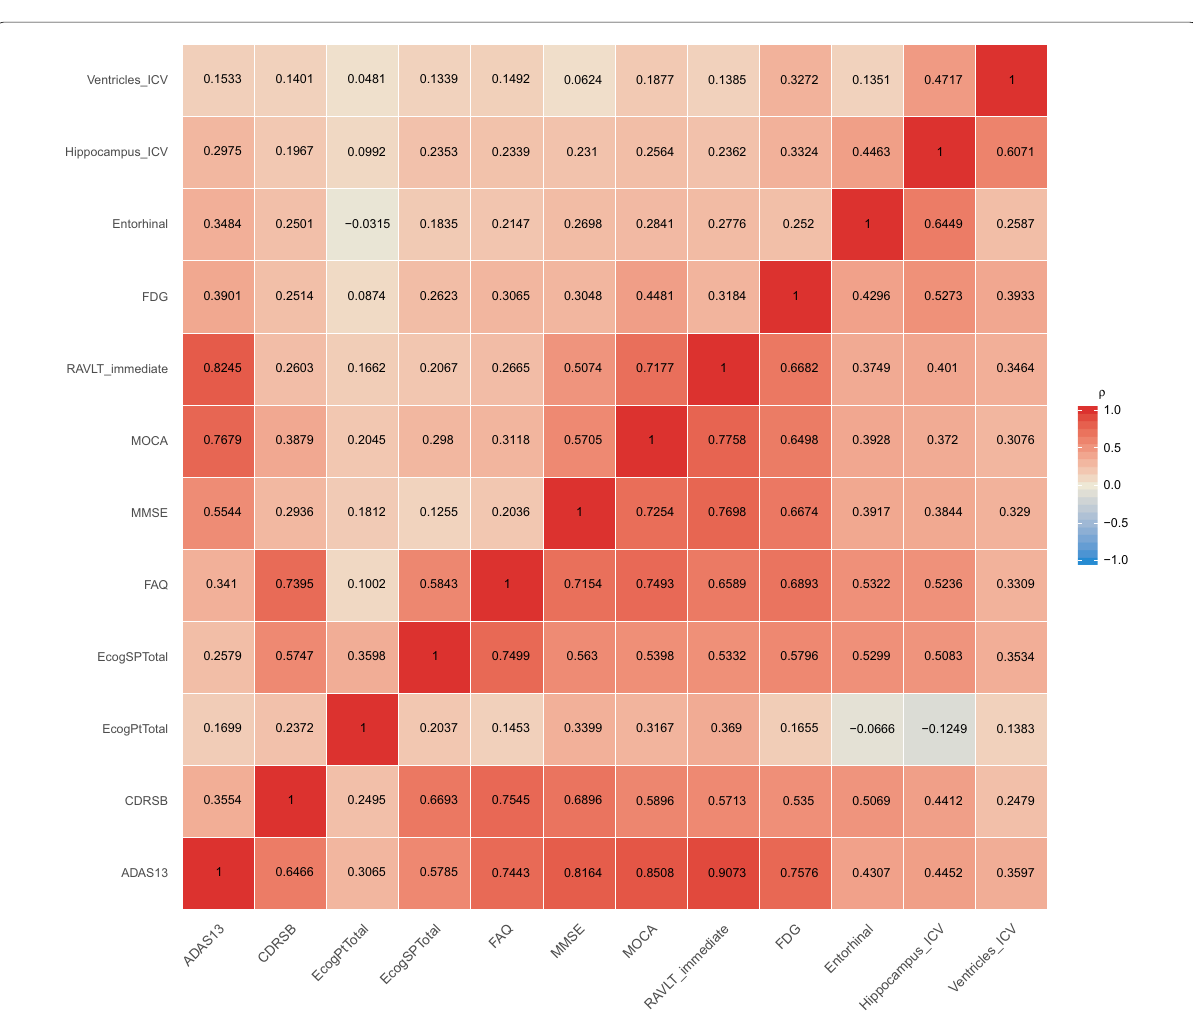
Fig. 2 For each pair of outcomes, the correlations among random intercepts are above the anti-diagonal, and the correlations among random slopes are below the anti-diagonal. ADAS13 Alzheimer’s Disease Assessment Scale, CDRSB Clinical Dementia Rating—Sum of Boxes,